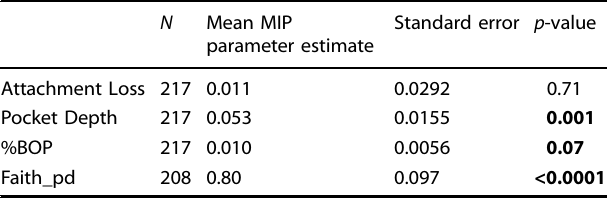
Table 2. Microbial indicator of periodontal disease (MIP) in saliva ( n = 282) and multiple measures of periodontal disease.